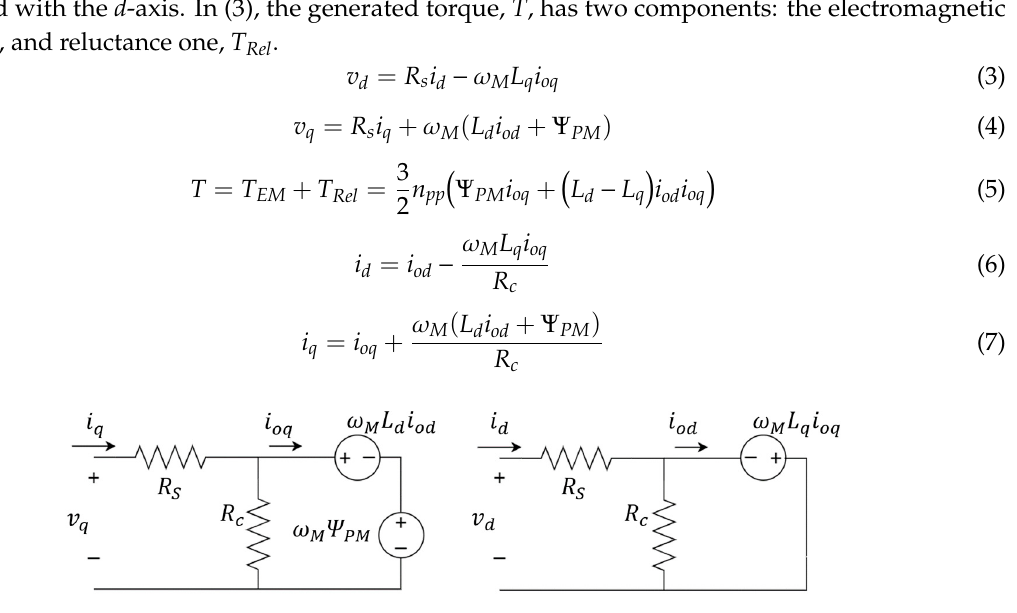
Figure 6. Synchronous machine equivalent circuit considering core-losses in d-q reference frame.